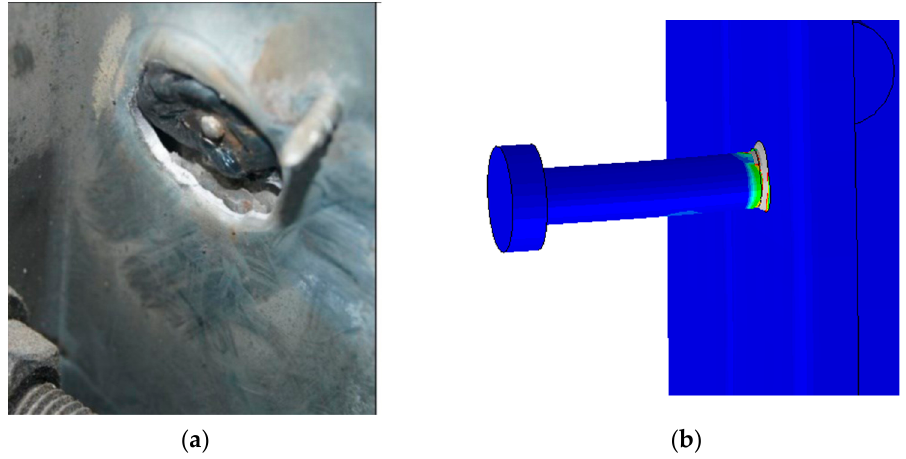
Figure 10. Plastic strain distribution from the FE model and pulling-out of the stud from test specimen. ( a ) Push test specimen. ( b ) Plasic strain in the FE model.